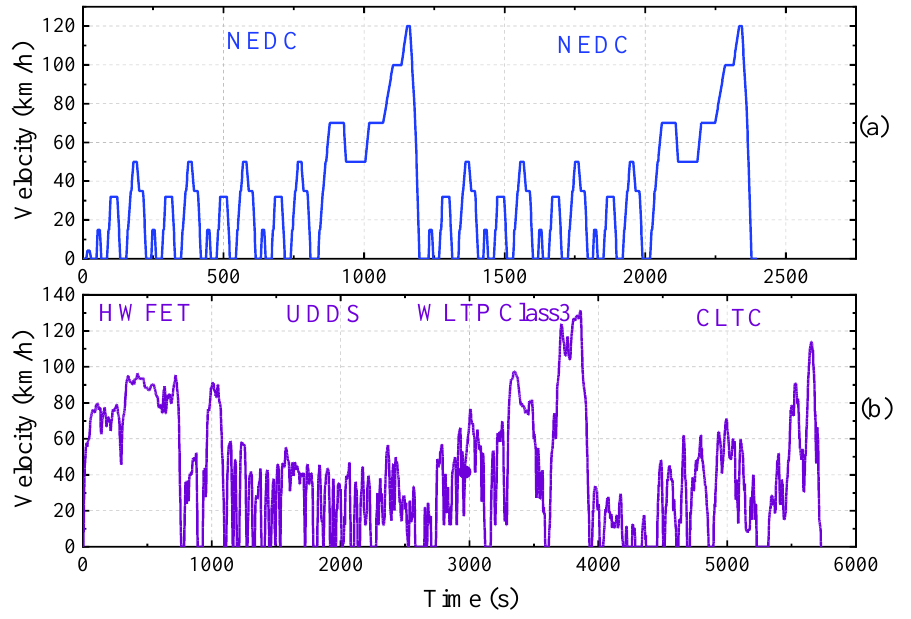
Figure 4. Driving cycles used for strategy training ( a ) and testing ( b ). Table 3. Comparative Features of Different